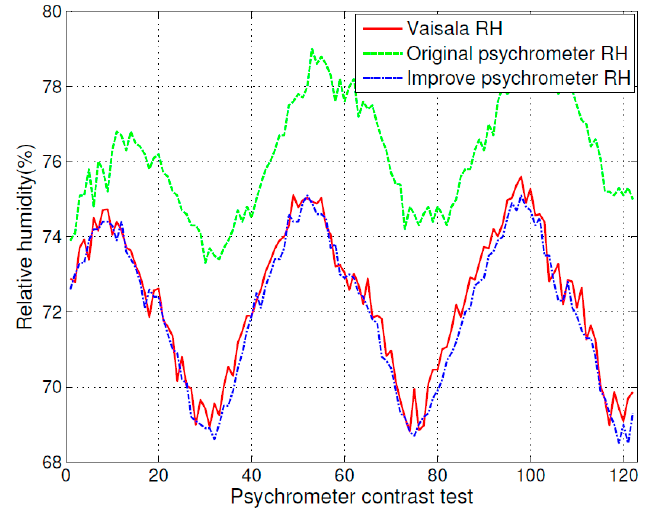
Figure 7. Comparison of relative humidity using the original psychrometer, the improved psychrometer, and the measurement instrument (HMP75), a zoomed part of Figure 6.